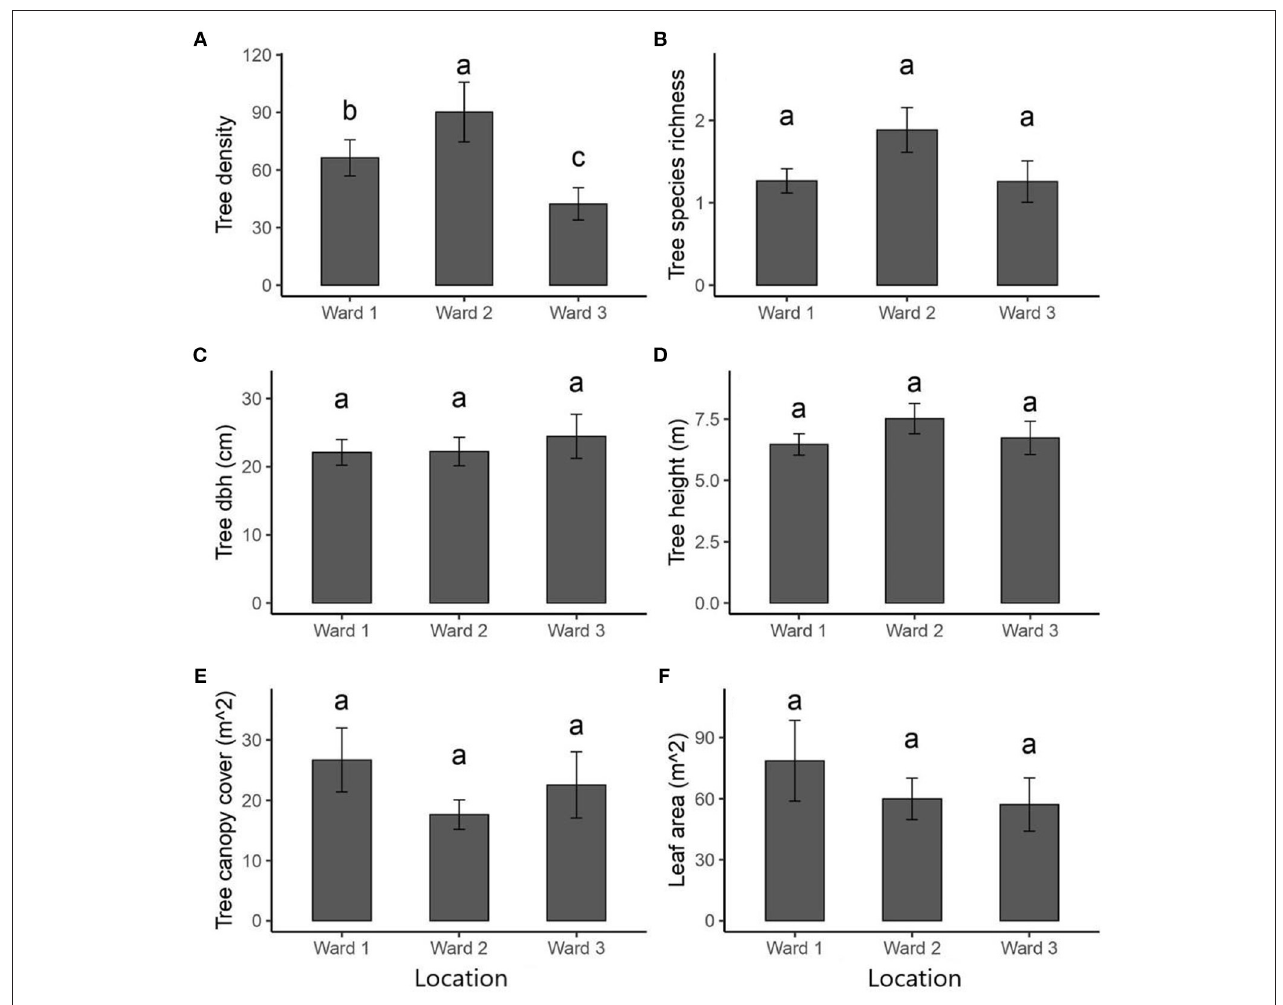
FIGURE 5 | Between-site variation in (A) plant density, (B) species richness (includes trees and shrubs), (C) diameter at breast height (dbh), (D) tree height, (E) canopy cover, and (F) leaf area among the three wards within the National District area of Santo Domingo, Dominican Republic. Dissimilar letters represent significant differences at a p -value = 0.05. Vertical lines (“T”) are standard error around the